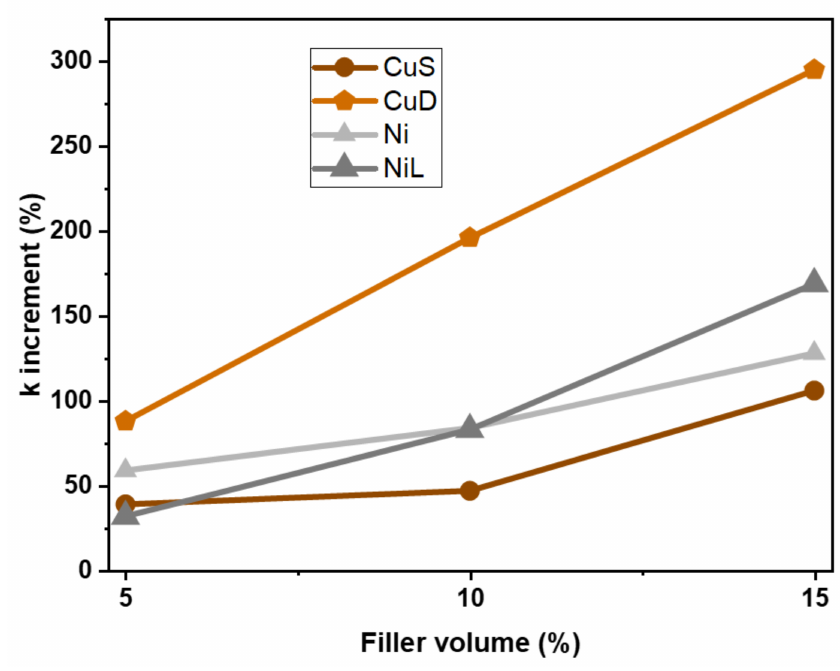
Figure 8. Percentage of k increment related to pristine Sylgard of the different metal-based